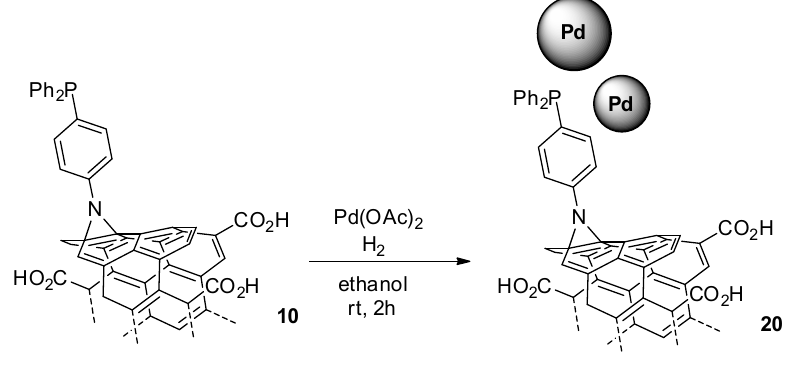
Figure 2. ( a ) Transmission electron microscopy (TEM) image of nanocomposite 20 ; ( b ) Size distribution of Pd(0) nanoparticles (mean value = 2.3 nm, σ = 0.6 nm. In a previous experiment Fareghi et al. [24] synthetized trans-stilbene ( 24 ) (among many other substrates in a detailed study), via Heck reaction, in one cycle with 95% yield, exploiting a catalytic system consisting of immobilized Pd nanoparticles on phosphine-functionalized graphene. We tested catalyst 20 to synthesize the same product in four different cycles starting from iodobenzene ( 21 ) and styrene ( 22 ). (Scheme 6) The results are reported in Table 6 (Entry 1). Comparing the amount of Pd used by Fareghi and coworkers [24] (1.7 mol%) with our system 20 (0.92 mol%), the results are good. In our case, the decrease in performance recorded for the last reaction cycle can be explained with